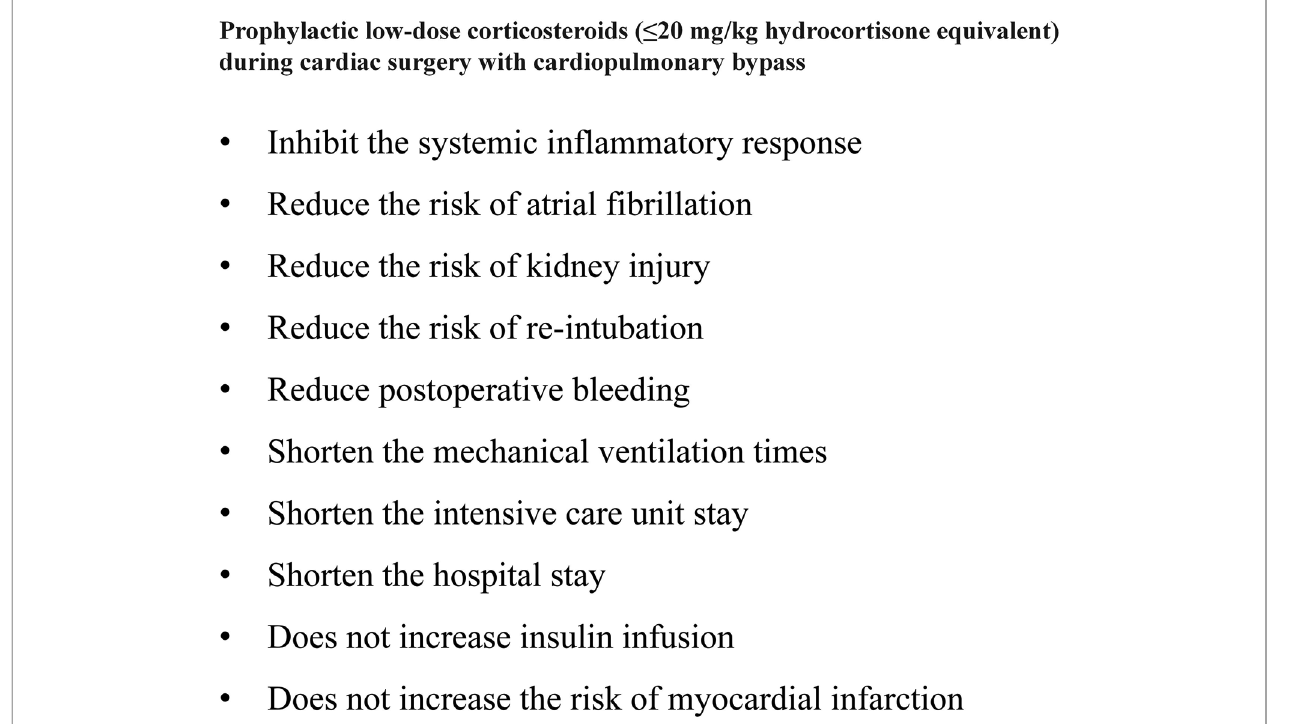
FIGURE 6 | Highlight of the impact of low-dose